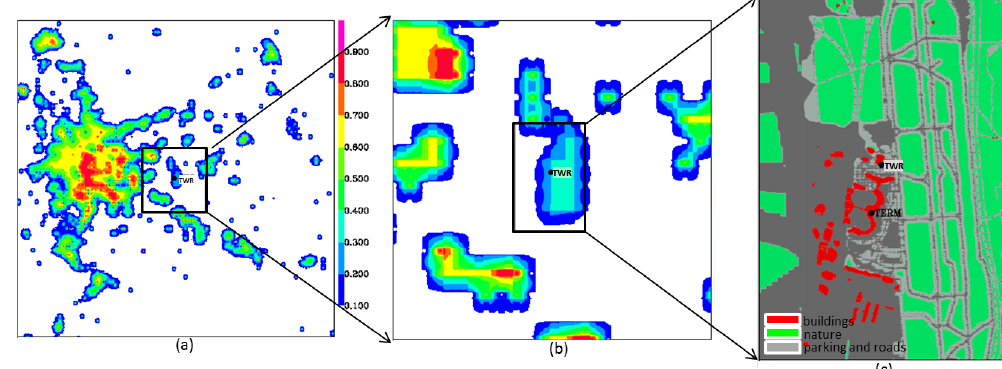
Figure 2. Fraction of urban cover on the three domains of simulation interacting in two-ways nesting two ways: ( a ) 250 m resolution, width = 67.5 km × 67.5 km; ( b ) 50 m resolution, width = 13.5 km × 13.5 km; ( c ) 10 m resolution, width = 3 km × 4.5 km.